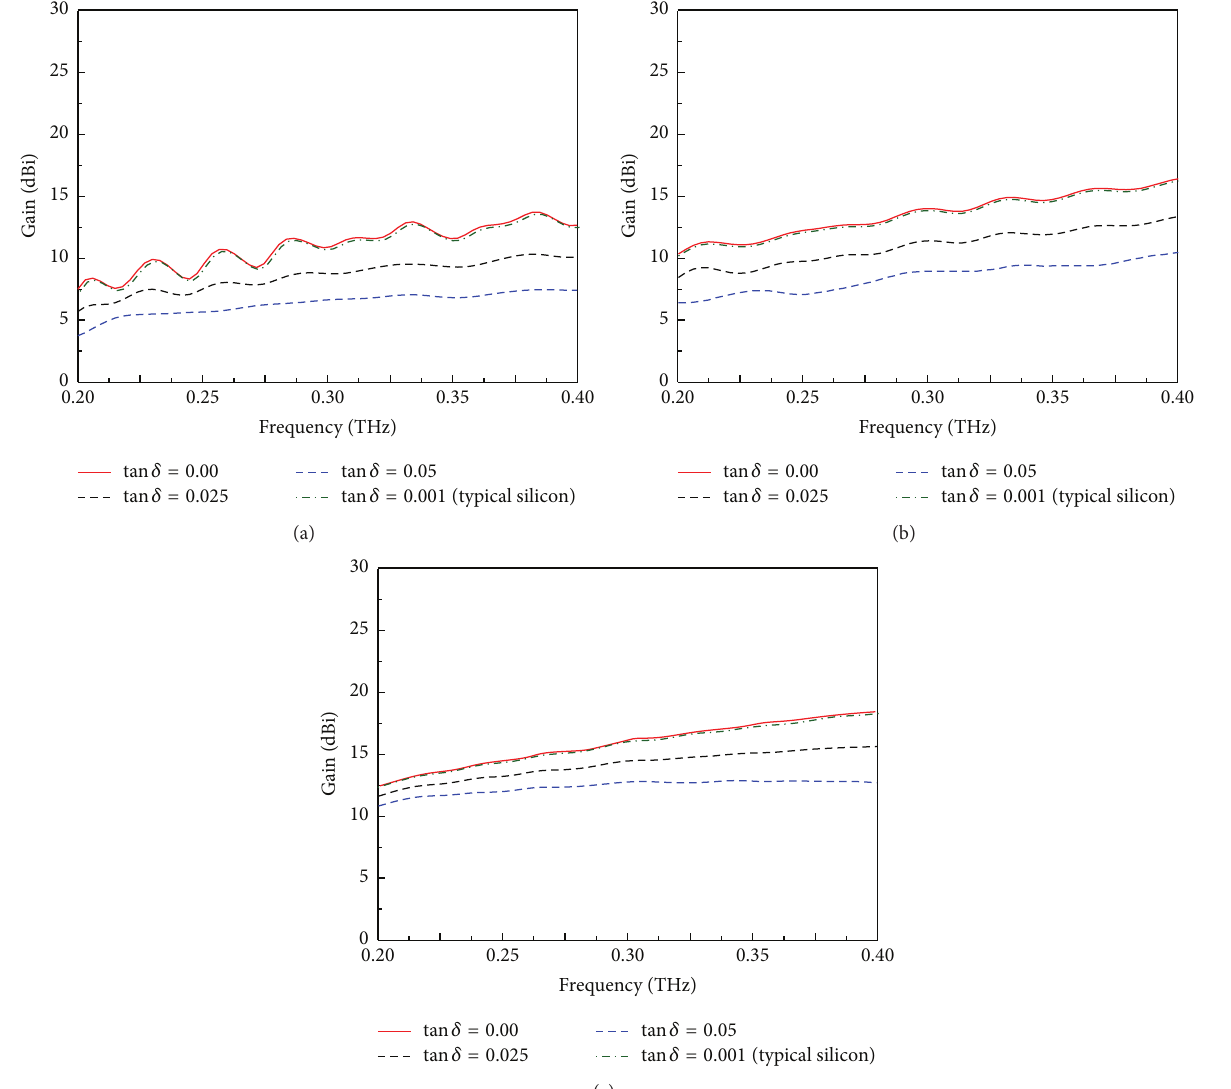
Figure 7: Comparison plots of antenna gain for silicon lenses with different values of loss tangent ( tan 𝛿) for (a) 𝑅 = 0.8 𝜆 𝑜 , (b) 𝑅 = 1.2 𝜆 𝑜 , and (c) 𝑅 = 1.6 𝜆 𝑜